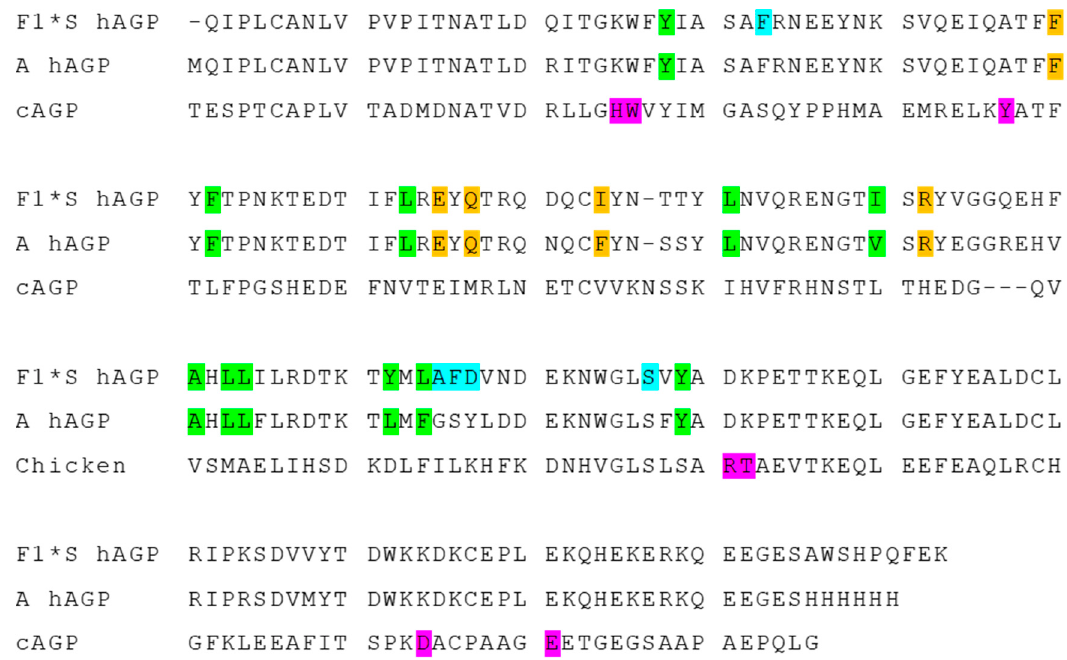
Figure 6. Sequence alignments of F1*S and A variant hAGPs and cAGP. The cavities in hAGP were called as lobes being highlighted in green for lobe I, orange for lobe II and cyan for lobe III. The amino acids, which consisted of feasible ligand-binding sites in this work, were colored in magenta.